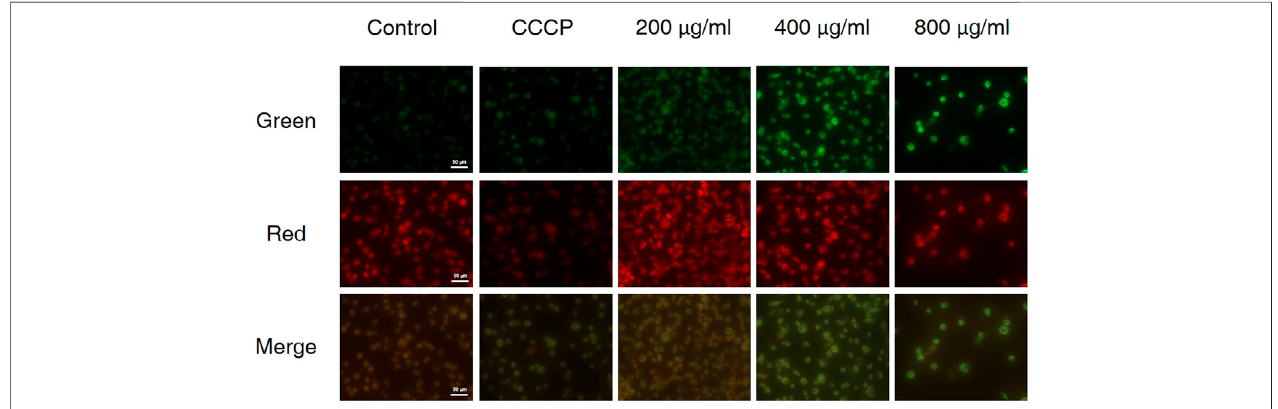
FIGURE 6 | AGS cells were analyzed by fl ow cytometry. (A – D) Photographs of AGS cells without or with CCS2 (200, 400 and 800 μ g/ml) treatment for 48 h. (E) Thepercentageoftotalapoptotic cells.Dataareexpressed astheaverageofthreeindependentexperiments. * p < 0.05,** p < 0.01, *** p < 0.001compared withcontrol.